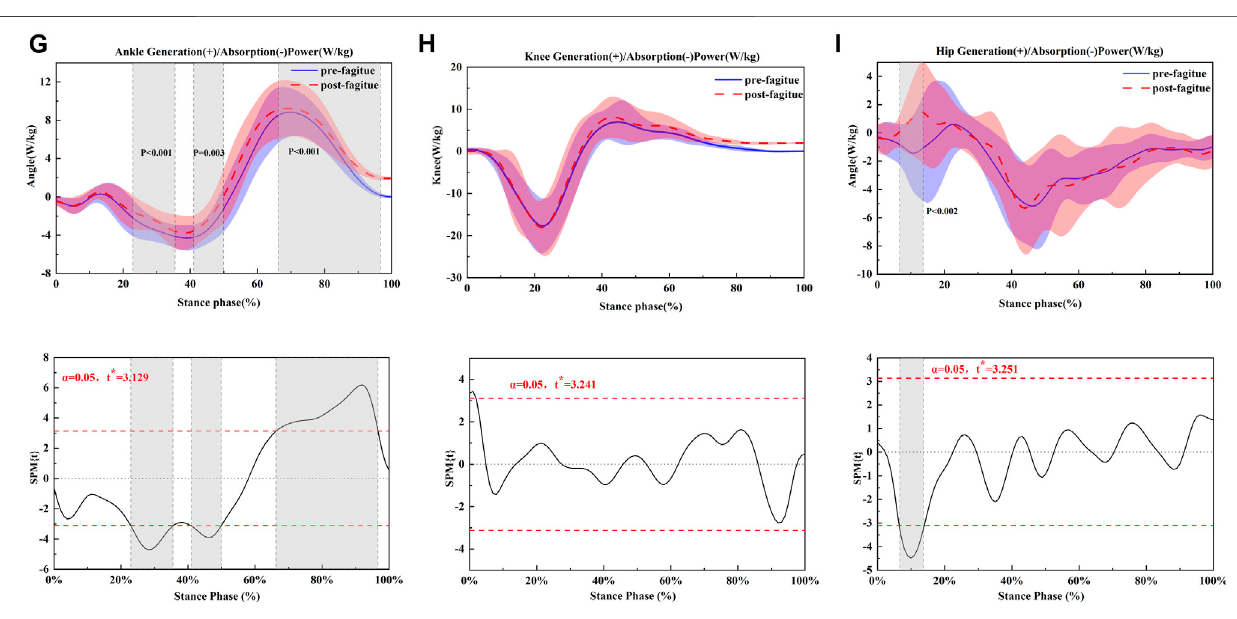
Frontiers in Bioengineering and Biotechnology |